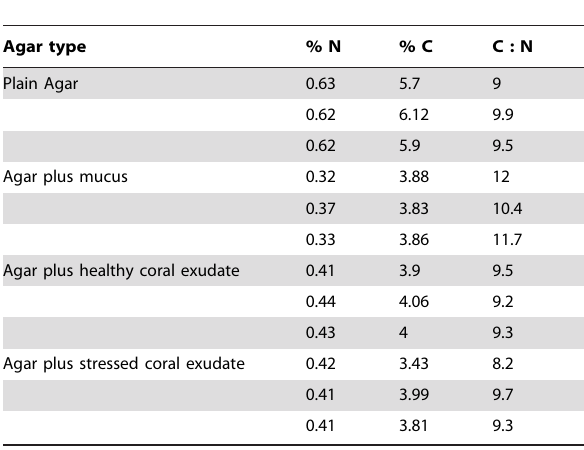
Table 1. Percentage carbon and nitrogen and resulting C:N ratio for the four agar